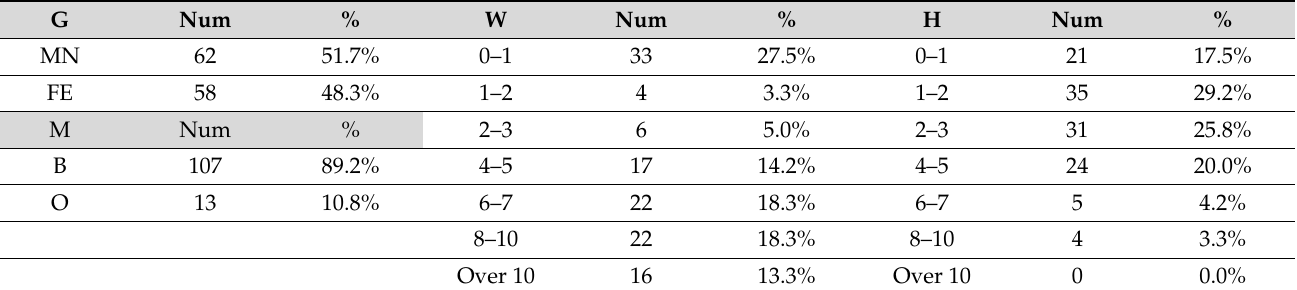
Table 3. Demographic data of the